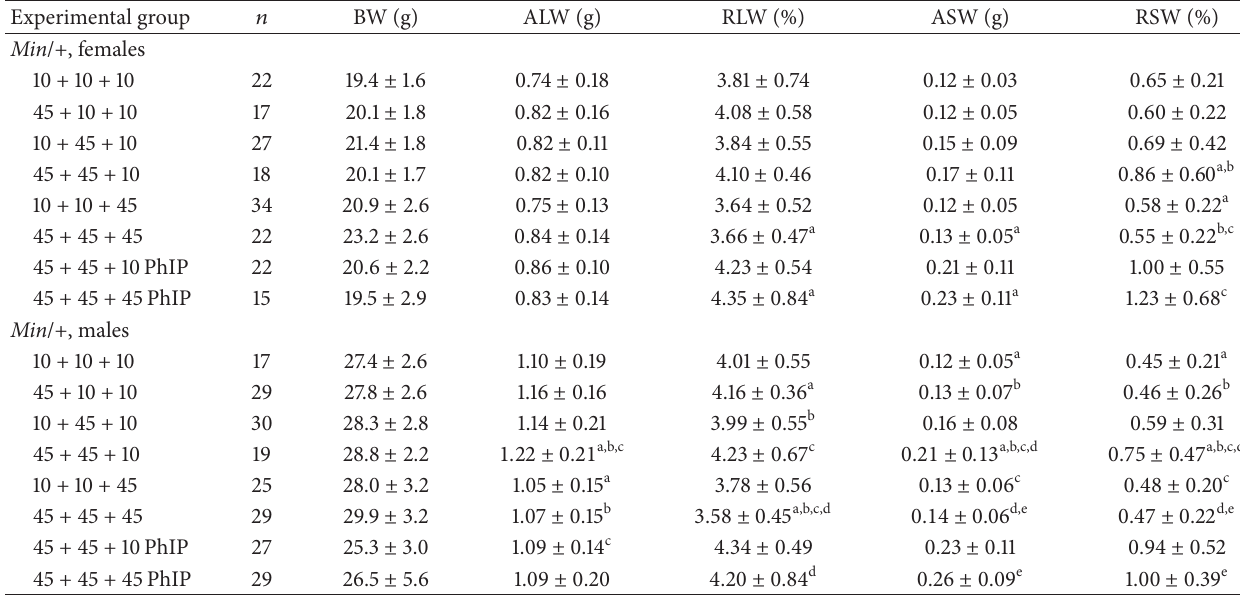
Table 1: Effects of exposure to a 45% fat diet during various periods of life on absolute liver weight (ALW), relative liver weight (RLW), absolute spleen weight (ASW), and relative spleen weight (RSW) in female and male Min/+ mice terminated at 11 weeks of age (mean of individual mice in the group ±